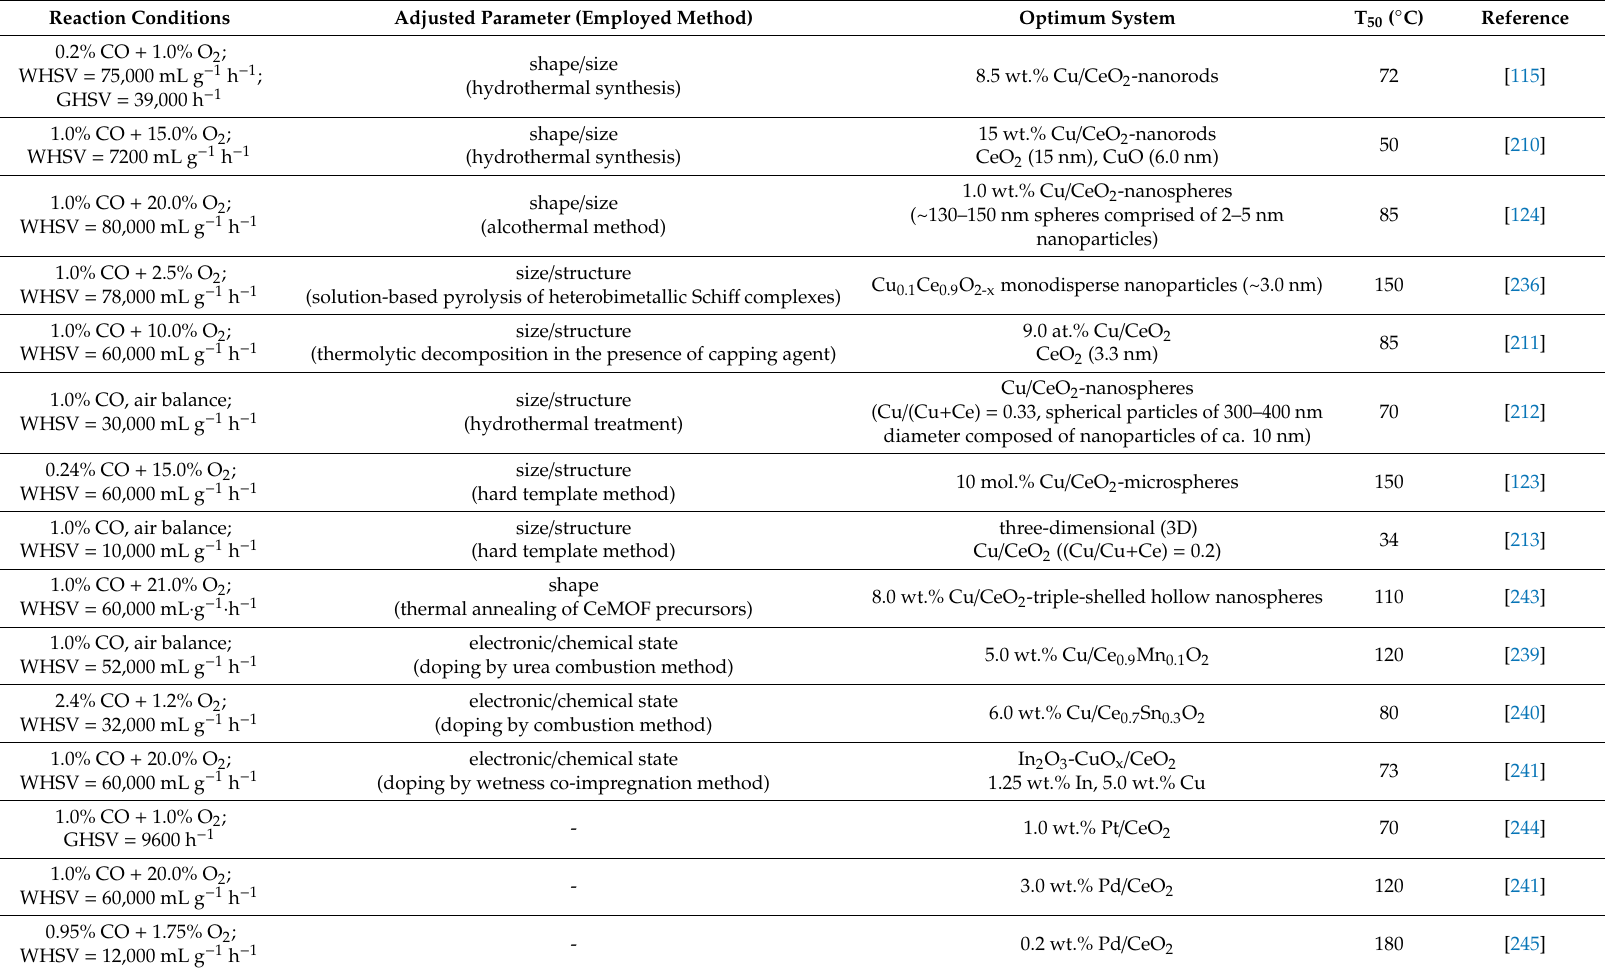
Table 1. Indicative studies towards adjusting the CO oxidation performance of CuO x / CeO 2